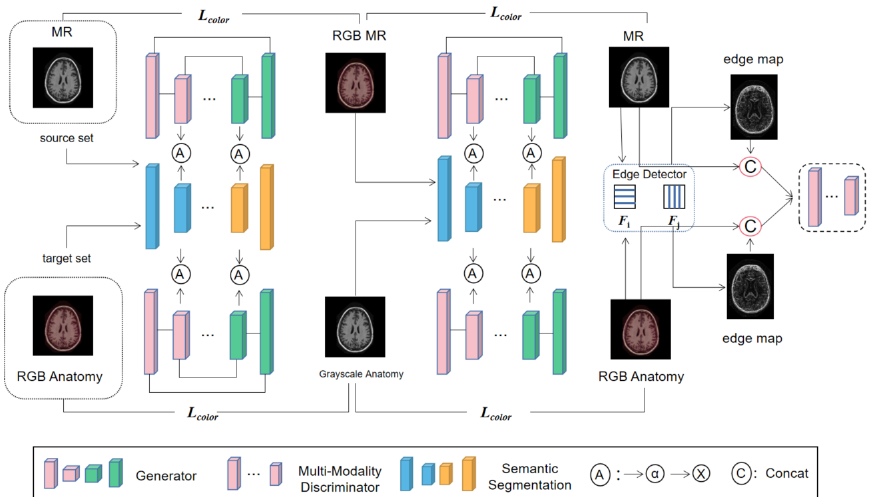
Figure 2. Framework of the proposed method. It takes grayscale MR images as the source domain and RGB anatomical images as the target domain, which are input into the framework. The generator features and segmentation network features are weighted by an attention module, which is then fed back into the generator, producing colorful MR images. Furthermore, the method includes an edge extraction module to constrain the edge and structural information in the generation by means of an edge loss and a multi-modal